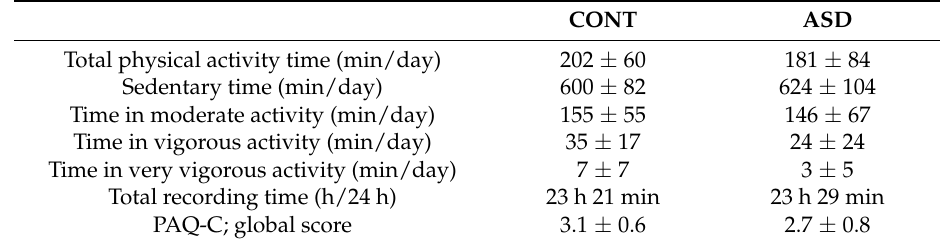
Table 3. Results of physical activity evaluation by actigraphy and questionnaire. CONT